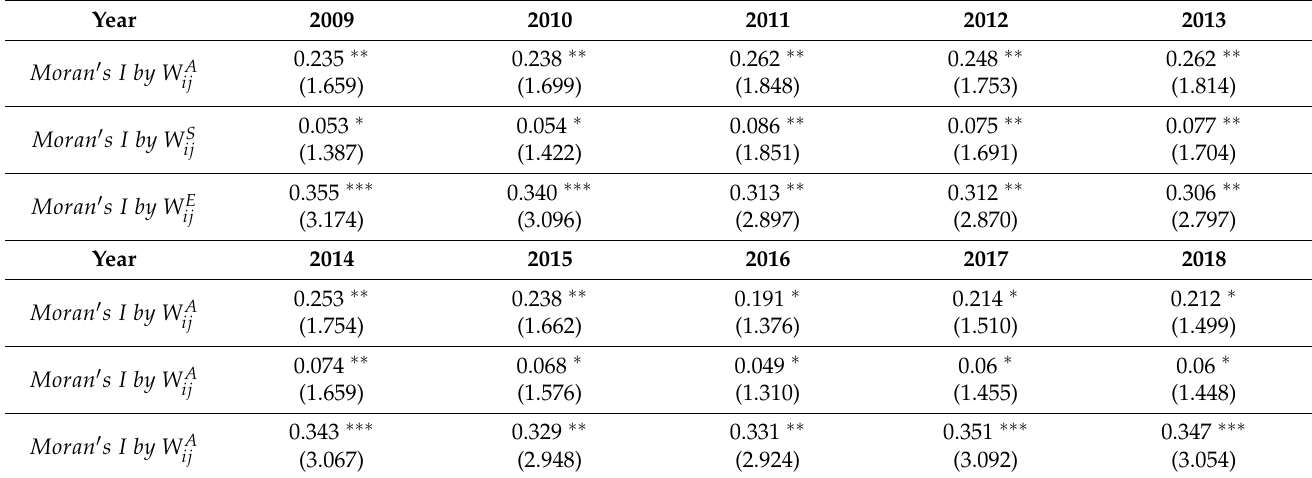
Table 5. Global spatial autocorrelation of Chinese ports from 2009 to